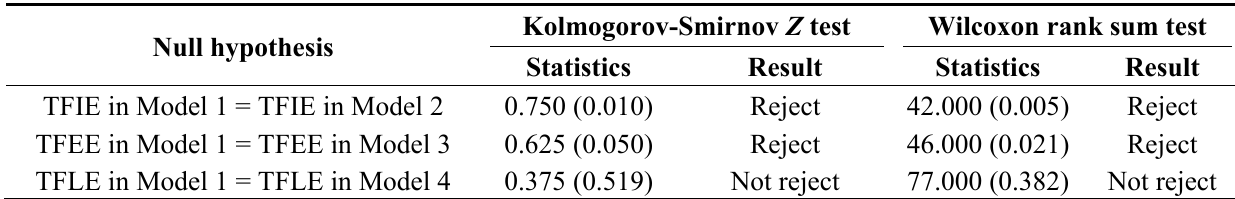
Table 1. Test for statistical difference of total-factor efficiency (TFE) since 2003 between target Model 1 and benchmark models. TFEE: total-factor energy efficiency; and TFLE: total-factor land